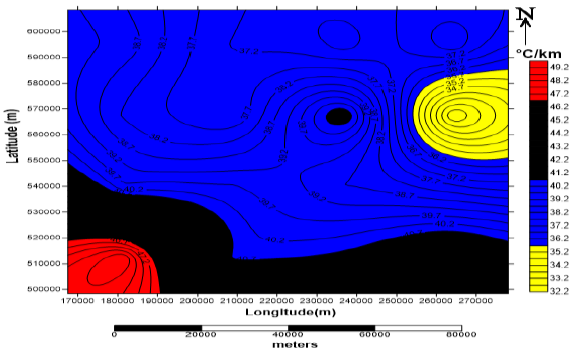
Figure 14: Curie depth map of the study area.